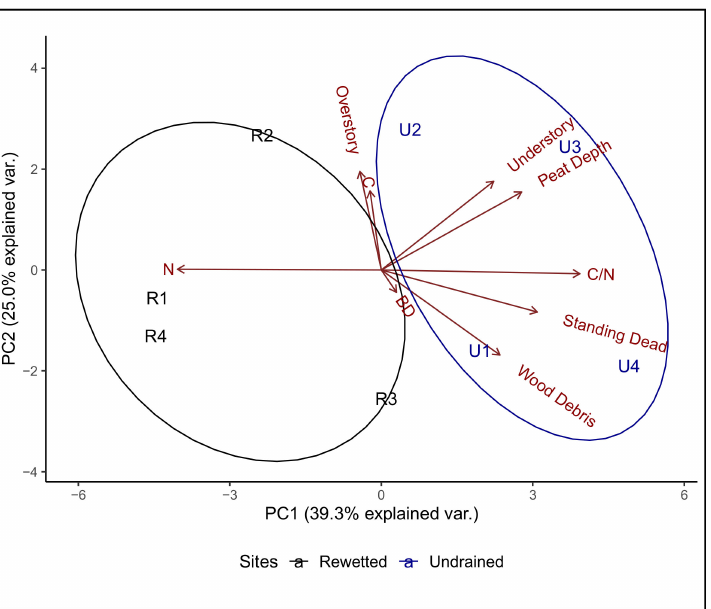
Figure 8. Principal component analysis (PCA) generated from soil property data (peat depth, bulk density (BD), carbon content (C), nitrogen content (N), C:N ratio (C/N), and carbon stocks from several pools (overstory, understory, standing dead wood, and wood debris), calculated from rewetted plots (R1, R2, R3, and R4) and undrained plots (U1, U2, U3, and